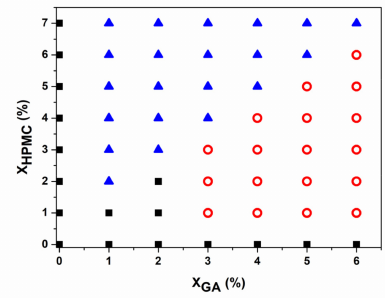
Figure 1. Phase diagram of the GA/HPMC blends quenched to 25 ◦ C. (cid:4) indicates a single liquid phase; o corresponds to a single gel system, and (cid:78) represents a phase separation system that includes a liquid phase (HPMC) as the top layer and a gel phase (GA) as the bottom